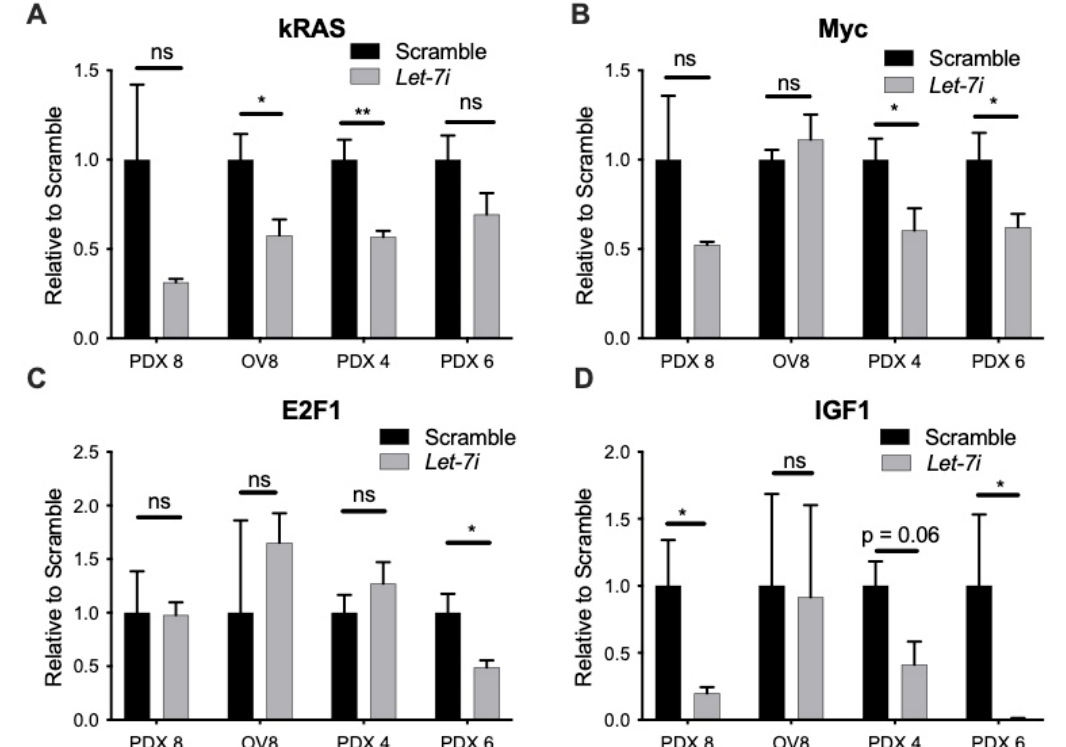
Figure 5. Let-7 represses targets involved in HR pathway. RT-qPCR demonstrates let-7i effect on KRAS ( A ), MYC ( B ), E2F1 ( C ), and IGF1 ( D ). Student’s t test used for statistical analysis. N = 3+ independent replicates. Error bars: SEM. * p ≤ 0.05, ** p ≤ 0.01. p value ≤ 0.05 was considered significant. ns, not significant.